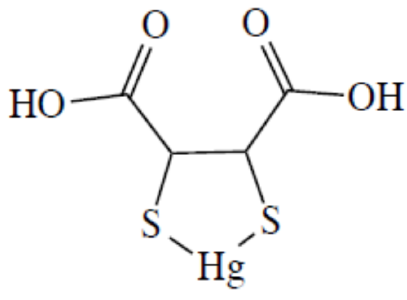
Figure 8. The molecular formula of DMSA–Hg complex proposed by Rivera et al. [193].